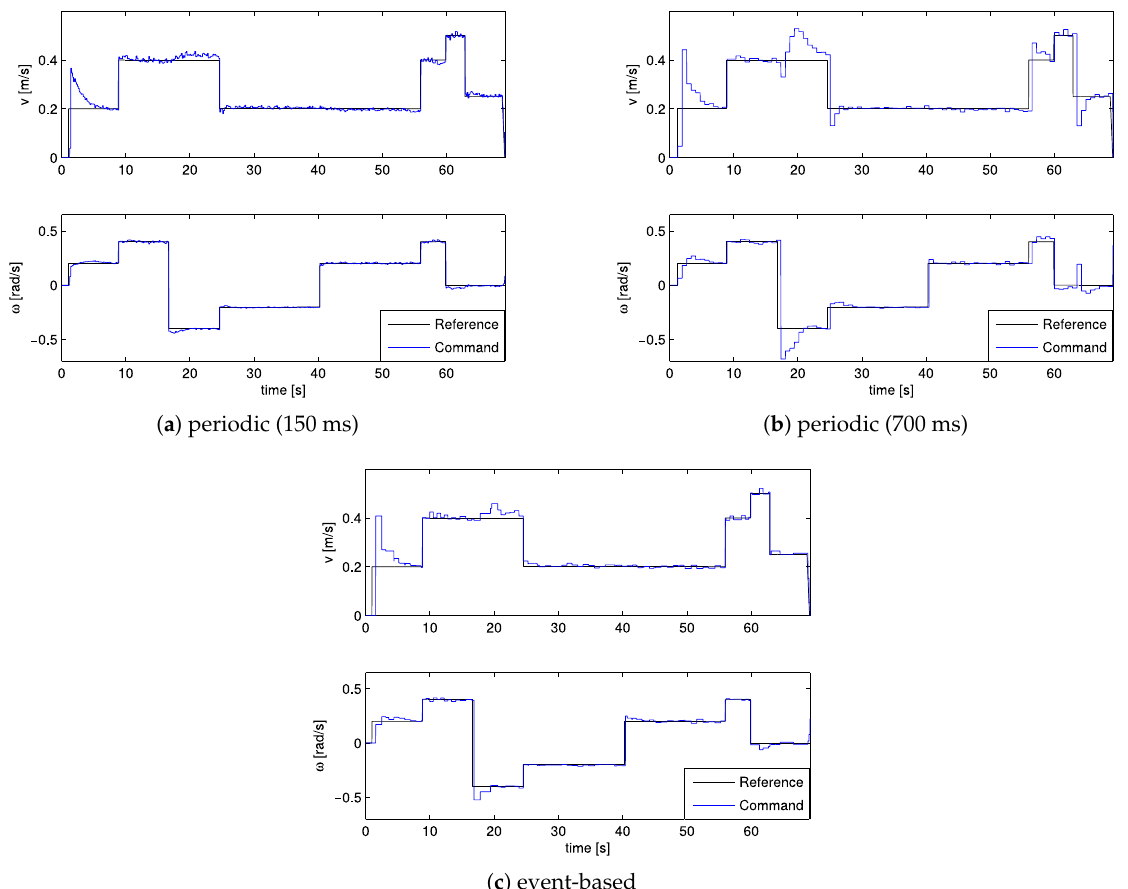
Figure 8. Reference and speed commands sent to the robot.